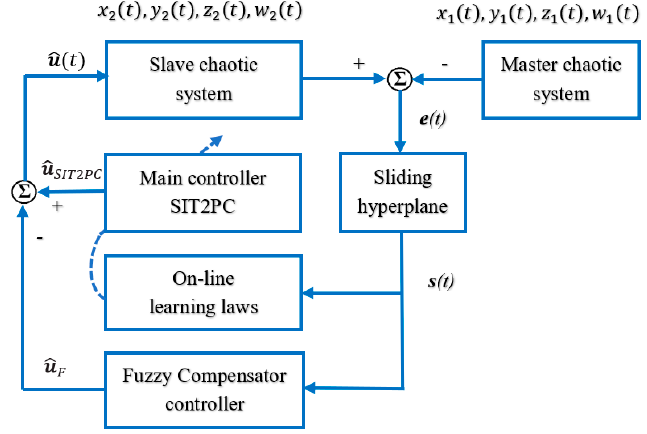
Figure 1. Block diagram of self-evolving recurrent interval type-2 Petri cerebellar model articulation controller (SRIT2PC) synchronization system.